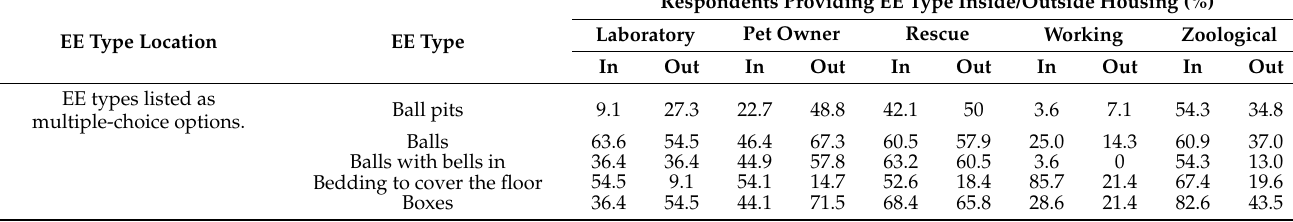
Figure 2. Number of enrichment types reported by caretakers to be provided inside ( a ) and outside of ferret housing ( b ) by sector. Boxes show median and first and third quartiles. Table 3. Percentage of respondents providing each EE type listed in a multiple-choice answer, either inside ferret housing (columns headed ‘In’), or outside ferret housing (columns headed ‘Out’) during out-of-cage exploration time. Respondents could select all EE types they provide, so the number of responses exceeds the number of respondents. EE types are listed in alphabetical